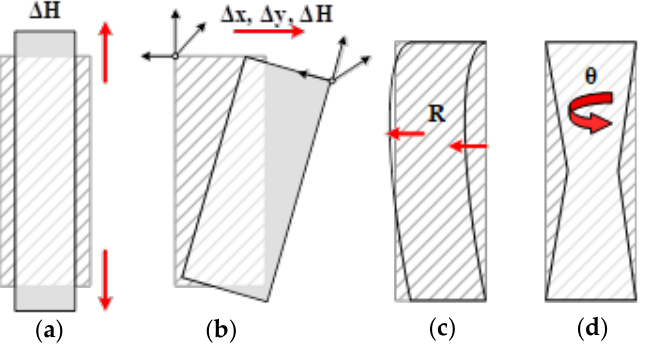
Figure 1. Monitoring parameters: ( a ) vertical displacements; ( b ) roll; ( c ) bending; ( d ) torsion.